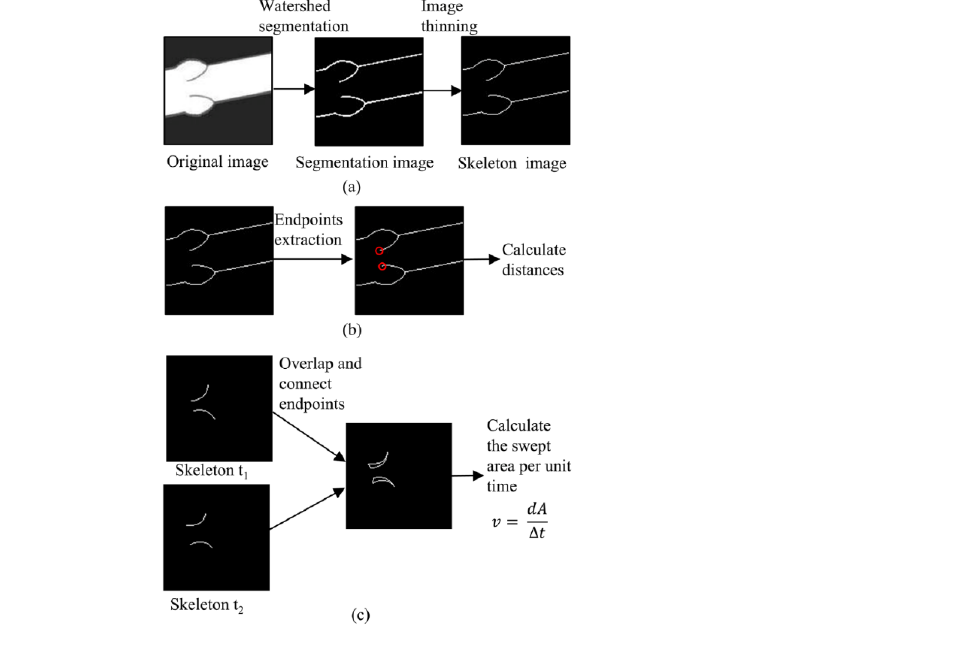
Figure 4. Detail of motion feature extraction. ( a ) Skeletonization process. ( b ) The process of endpoints distance extraction. The red circles in the figure represent the endpoints of the aortic valve. ( c ) The process of swept area velocity calculation.